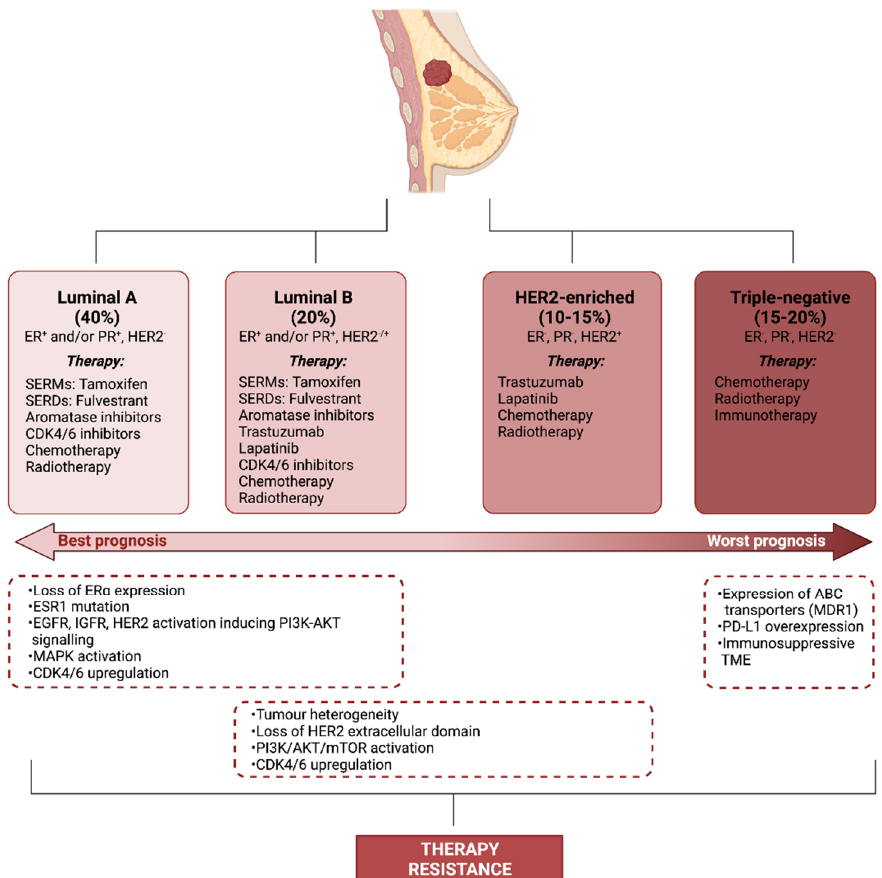
Figure 1. Breast cancer subtypes, standard treatments and mechanisms of therapy resistance. BC can be classified into four main subtypes based on the expression of oestrogen receptor (ER), progesterone receptor (PR) and human epidermal growth factor receptor 2 (HER2). Different treatments are administered based on the molecular markers. Several mechanisms of therapy resistance can arise in the different BC subtypes. (Abbreviations: ABC, ATP-binding cassette; CDK4, cyclin dependent kinase 4; CDK6, cyclin dependent kinase 6; ER α , oestrogen receptor α ; EGFR, epidermal growth factor receptor; ESR1, oestrogen receptor 1; IGFR, insulin-like growth factor receptor; MAPK, mitogen-activated protein kinase; mTOR, mammalian target of rapamycin; PD-L1, pro- grammed death ligand 1; PI3K, phosphatidylinositol-3-kinase; SERMS, selective oestrogen receptor modulators; SERDS, selective oestrogen receptor downregulators; TME, tumour microenviron- ment).